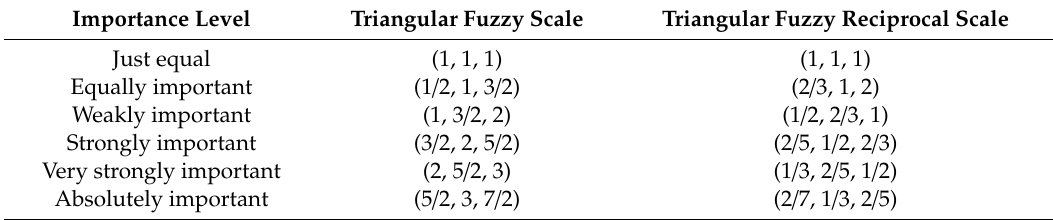
Table 1. Linguistic scale conversion to the triangular fuzzy number (TFN)